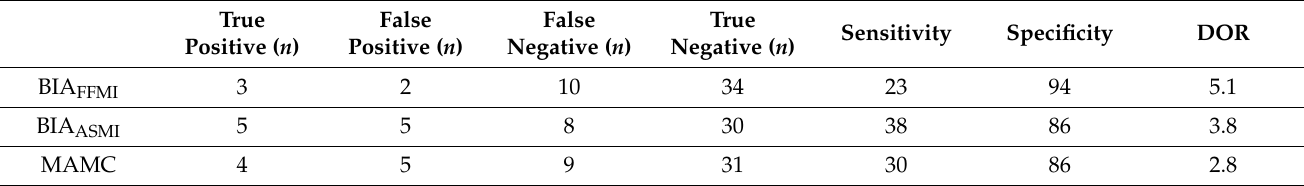
Table 4. Accuracy of BIA and MAMC in identifying patients with low muscle mass with CT PMI as the reference method.